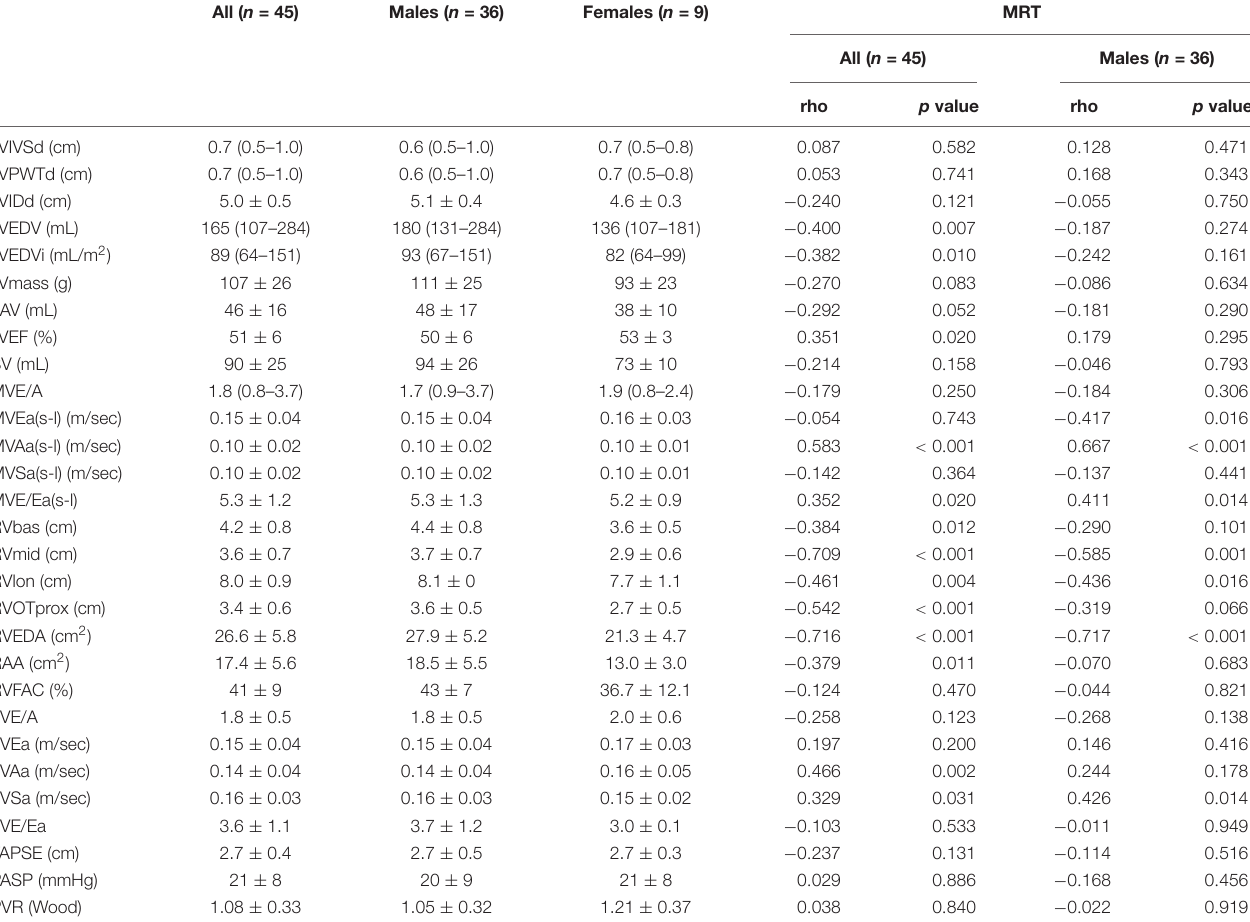
TABLE 3 | Values of echocardiographic parameters and their relationship with marathon race time (MRT). All ( n =